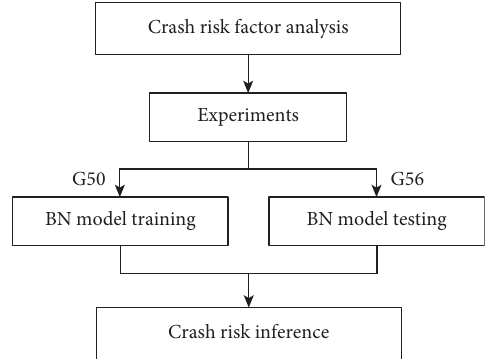
Figure 1: Framework of the study, wherein “G50” and “G56” stand for data collected from Freeways G50 and G56,